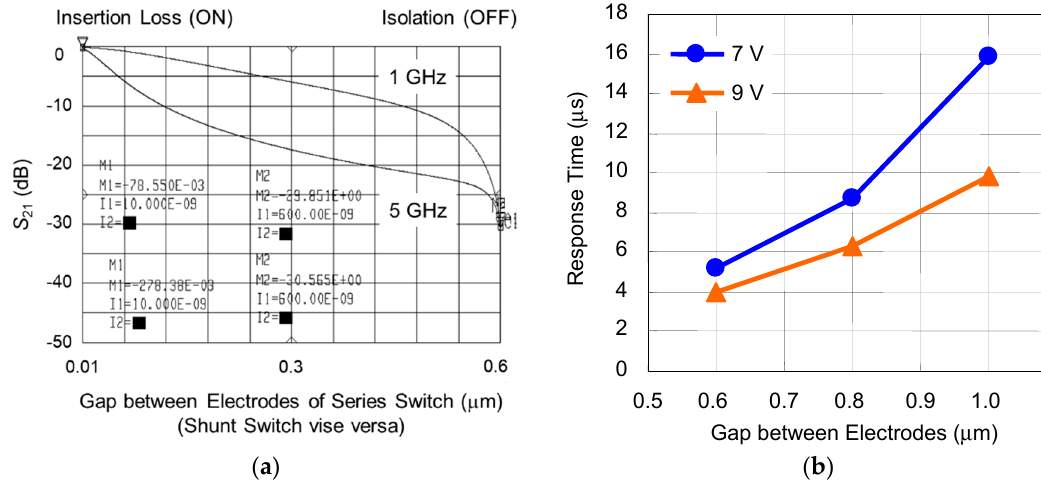
Figure 3. ( a ) Simulated RF characteristics as a function of gap between electrodes of series shunt hybrid switches; ( b ) simulated response time as a function of gap between electrodes.